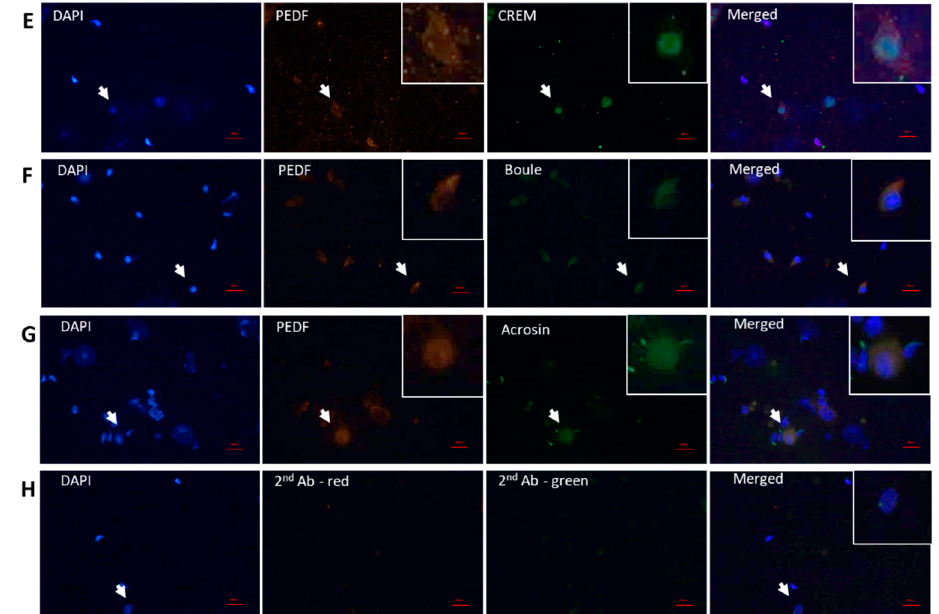
Figure 3. Cellular localization of PEDF in testicular spermatogenic cells. Methanol-fixed cells were used to stain premeiotic and meiotic/postmeiotic cells as described in Figure 2. ( A ) α 6-integrin, ( B ) GFR- α , ( C ) CDH1, ( D ) and NC—IF staining without the presence of primary antibody. ( E ) CREM, ( F ) Boule, ( G ) Acrosin and ( H ) NC—IF staining without the presence of primary antibody. Scale bar: 100 μ m.